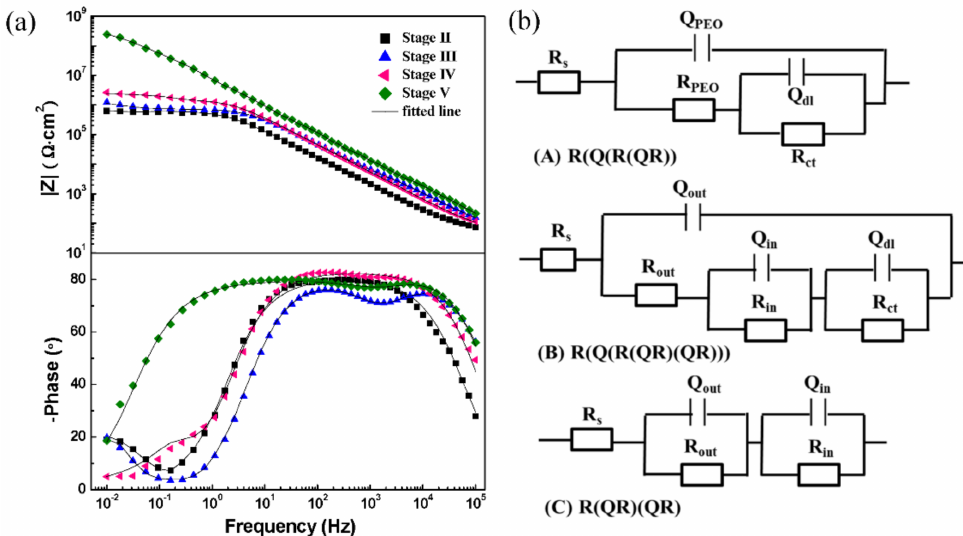
Figure 8. ( a ) Bode plots and ( b ) equivalent circuits of PEO coatings at different